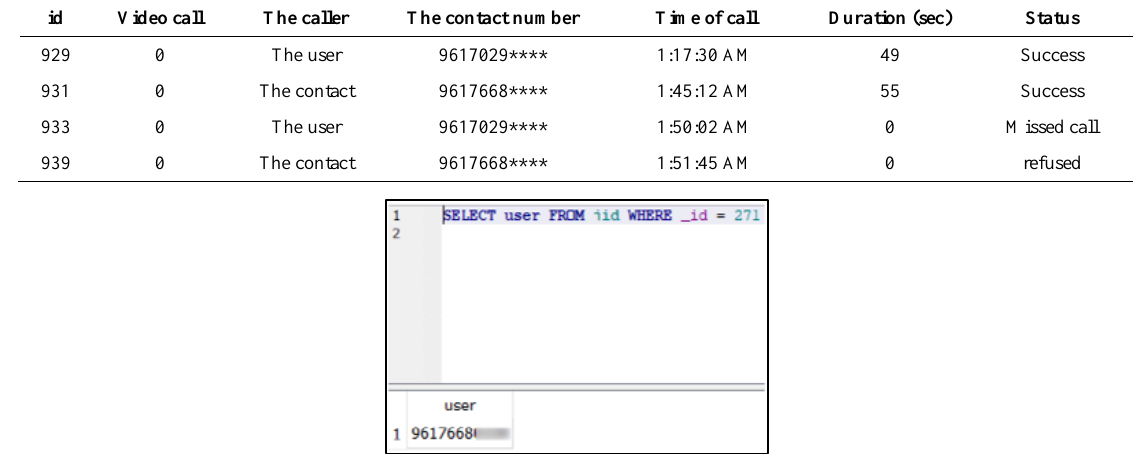
Figure 26. User phone number